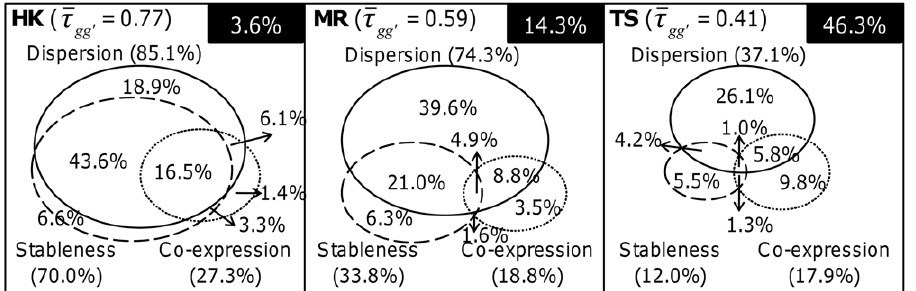
Figure 4. The contributions to the ranking preservation of the HK, MR, and TS genes. The three contributing factors were dispersion (solid line), stableness (dashed line), and co-expression (dotted line). For each factor, its contribution (in parenthesis) was the sum of the individual contributions calculated using tensor product decomposing equations, such as Equation (11)–(13) . The contribution of factors other than these three is given in the black box in the upper right corner of each